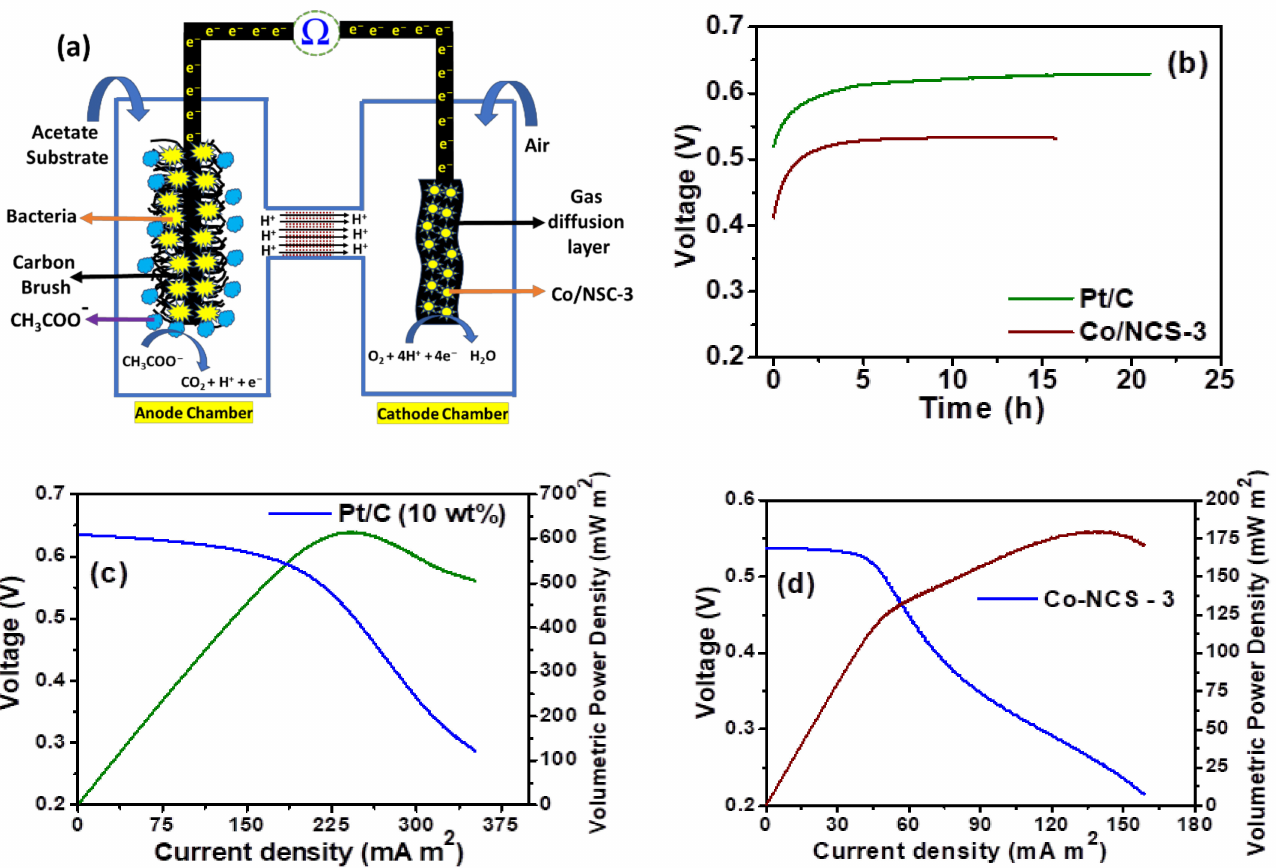
Figure 9. ( a ) Schematic representation of dual chamber microbial fuel cells ( b ) recorded OCV values of Co/NSC-3 and Pt/C (10 wt.%). The i-v characteristics of ( c ) Pt/C (10 wt.%) ( d ) Co-NSC-3 catalysts in dual chamber microbial fuel cells. Anolyte: 20 mM sodium acetate + pH 7 buffer, catholyte: Air saturated pH 7